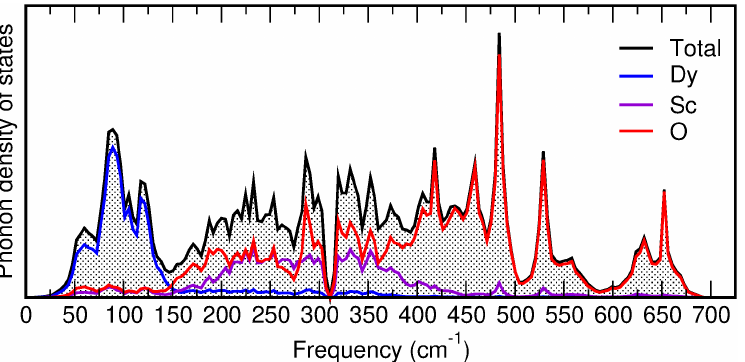
Figure 12. Total phonon density of states and contribution per species, as calculated at ambient pressure for DyScO 3